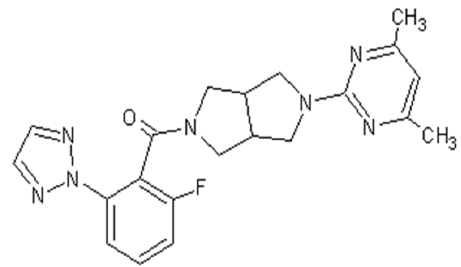
Molecules 2023 , 28 , x FOR PEER REVIEW Figure 2. Chemical formula of seltorexant, a selective orexin antagonist. Figure 2. Chemical formula of seltorexant, a selective orexin antagonist.